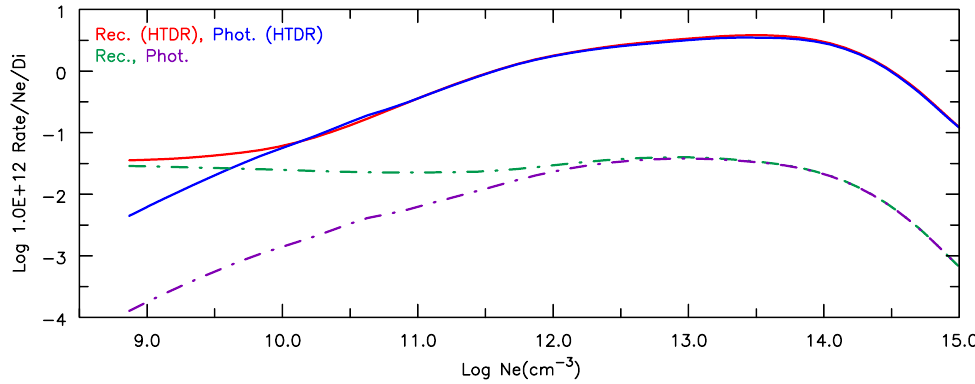
Figure 7. Illustration of the photoionization and recombination rates to/from a combined level (n = 26, . . . ,30; singlet levels only) in C III . The solid curves show the rates with HTDR included, while the dashed curves show the rates without HTDR included. At most densities the recombination and photoionization rates agree closely in the model with HTDR. In such regions the influence of HTDR on the ionization structure is suppressed. Towards the outer boundary the HTDR recombination rate converges to that of a model without HTDR due to the decrease in electron